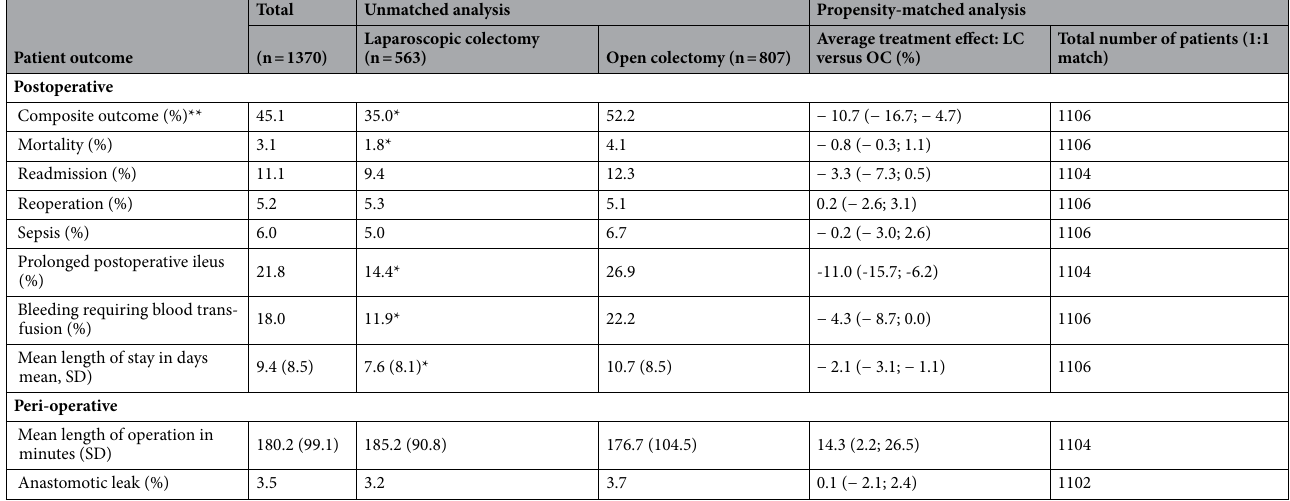
Table 2. Patient outcomes of laparoscopic versus open colectomy, NSQIP 2013–2015. * p < 0.05 in unadjusted LC (laparoscopic colectomy) versus OC (open colectomy) comparison; **Composite outcome includes readmission, reoperation, wound infection, blood transfusion, prolonged ileus, sepsis, myocardial infarction, deep vein thrombosis, pulmonary embolism, and mortality; SD: standard deviation.